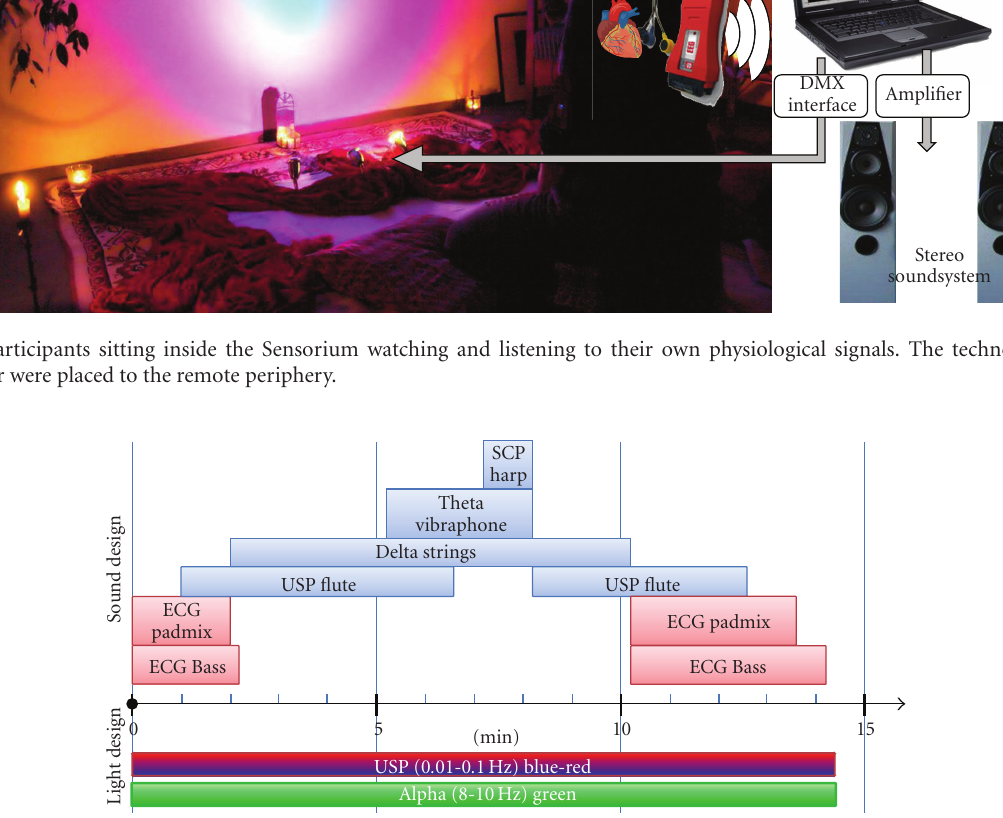
Figure 4: The sound and light design is depicted in a time flow graph. Inside the bars, the EEG component and the associated instrumentation are named. While the sound patterns changed during the time, the light parameters were kept